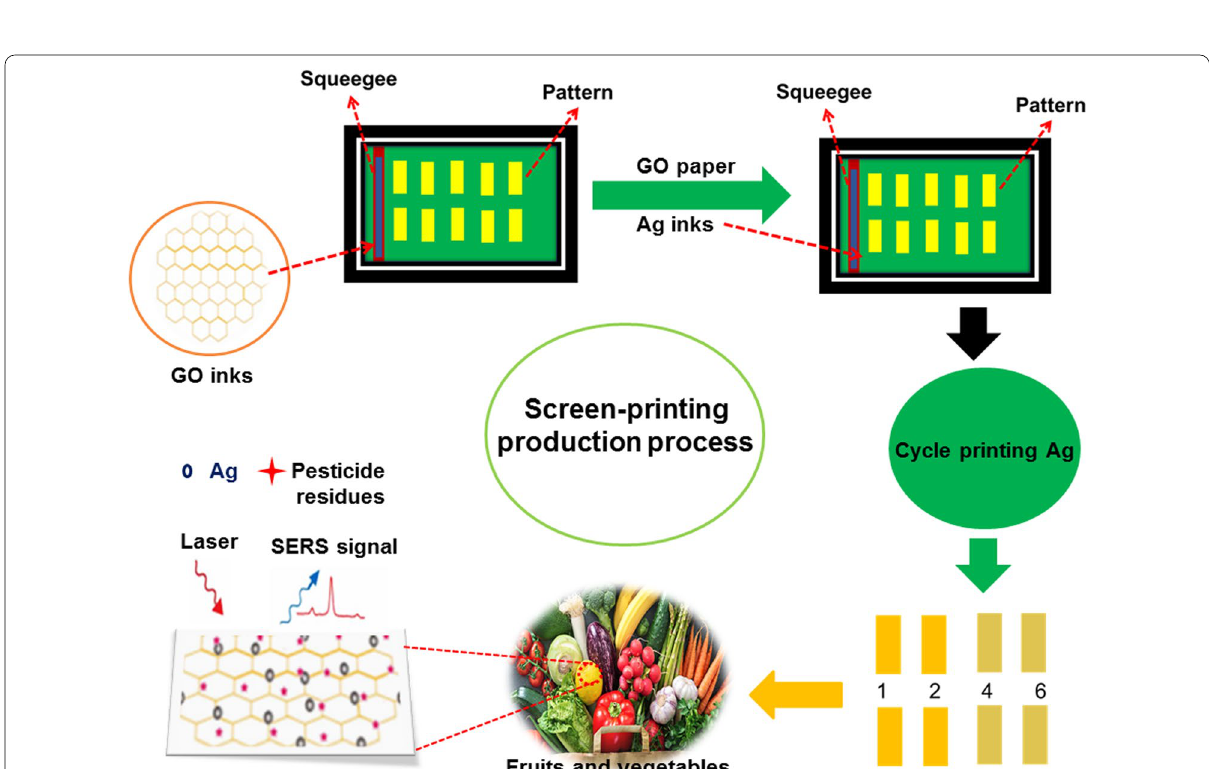
Fig. 3 Illustration of the screen-printing production process for SERS swabs its application to detect pesticides in fruits and